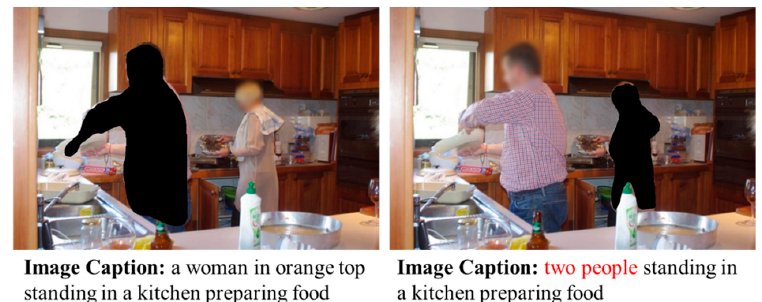
Figure 17. Misjudgment of the image captioning algorithm.